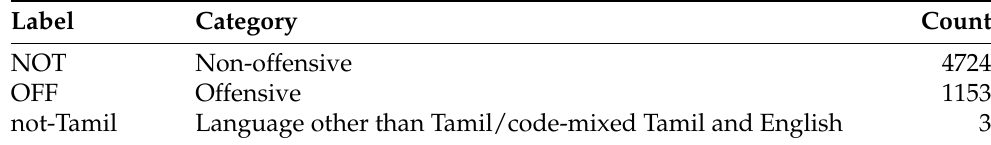
Table 1. HASOC’21 Dataset class